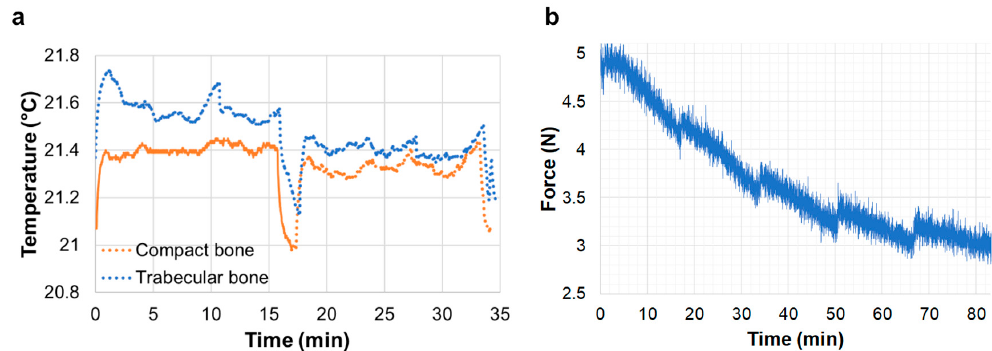
Figure 2. ( a ) Temperature readings measured using a thermocouple attached to the compact and trabecular bone surface at room temperature. The solid line corresponds to thermocouple readings during ~15 min with the X-ray shutter opened and the thermocouple in the beam path. Dotted lines represent thermocouple readings during tomographic acquisition. The sudden drop and consequent rise in temperature coincide with the closing and opening of the X-ray shutter. ( b ) Force readings in trabecular bone specimen at room temperature during five consecutive tomograms. An increase in the force was observed and corresponded with the opening of the X-ray shutter.